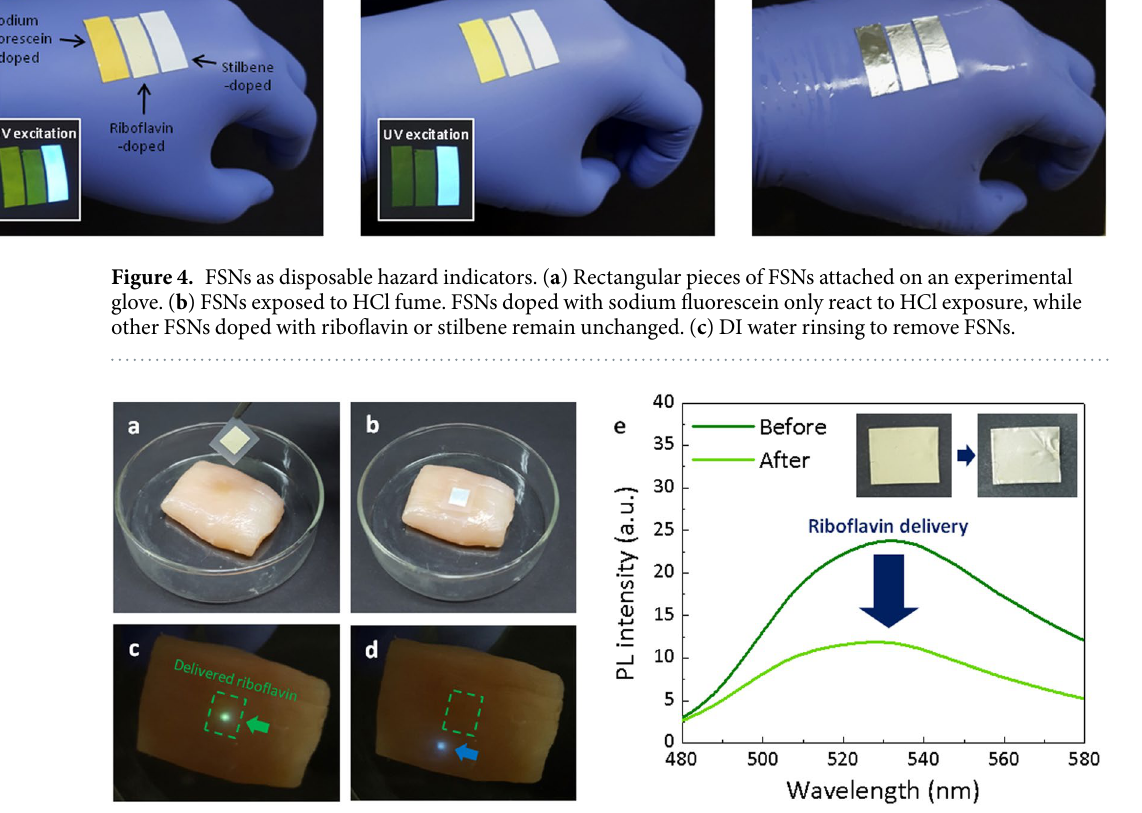
Figure 5. Simple model for a nutrient delivery system. ( a , b ) A riboflavin-doped FSN mat is placed on the surface of a raw chicken breast (as a biological tissue). ( c , d ) Confirmation of riboflavin delivery to the skin. The region on which the FSN mat was placed is marked with a green dotted square. Inside the green dotted square, delivered riboflavin responds to UV excitation (325-nm He-Cd laser) and shows green fluorescence. ( e ) Photoluminescence spectra of FSNs doped with riboflavin before and after vitamin delivery. Inset shows the change of the external color of the FSN